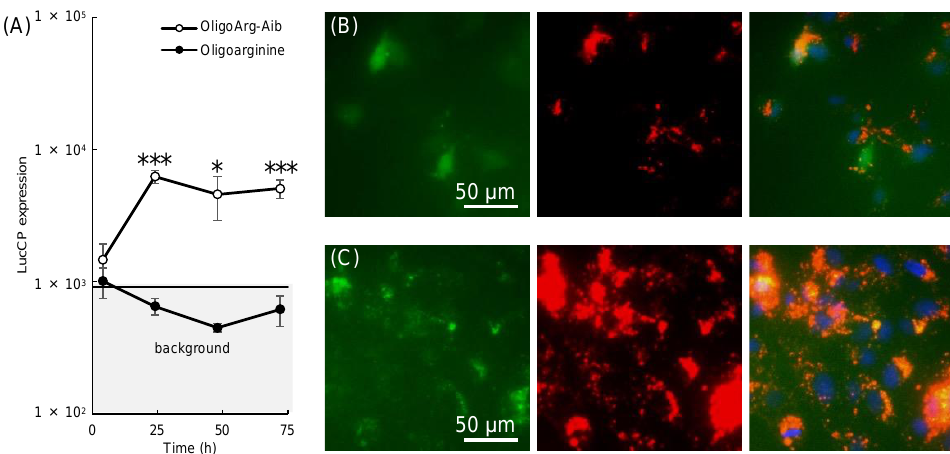
Figure 2. Oligoarginine- α -aminoisobutyric acid (OligoArg-Aib) for cell-penetrating peptides (CPPs) for prolonged protein expression from mRNA. ( A ) Expression of a destabilized reporter protein after its introduction using oligoarginine/mRNA and OligoArg-Aib/mRNA complexes. Statistical analyses were performed using Student’s t -test. *, p < 0.05, ***, p < 0.001. ( B , C ) Fluorescence micro- scopic images of cells 24 h after treatment with oligoarginine/mRNA ( B ) and OligoArg-Aib/mRNA ( C ) complexes. Green: fluorescein-labeled peptides, Red: Cy5-labeled mRNA. Figures are adapted with permission from [49] , published by Royal Society of Chemistry, 2021.